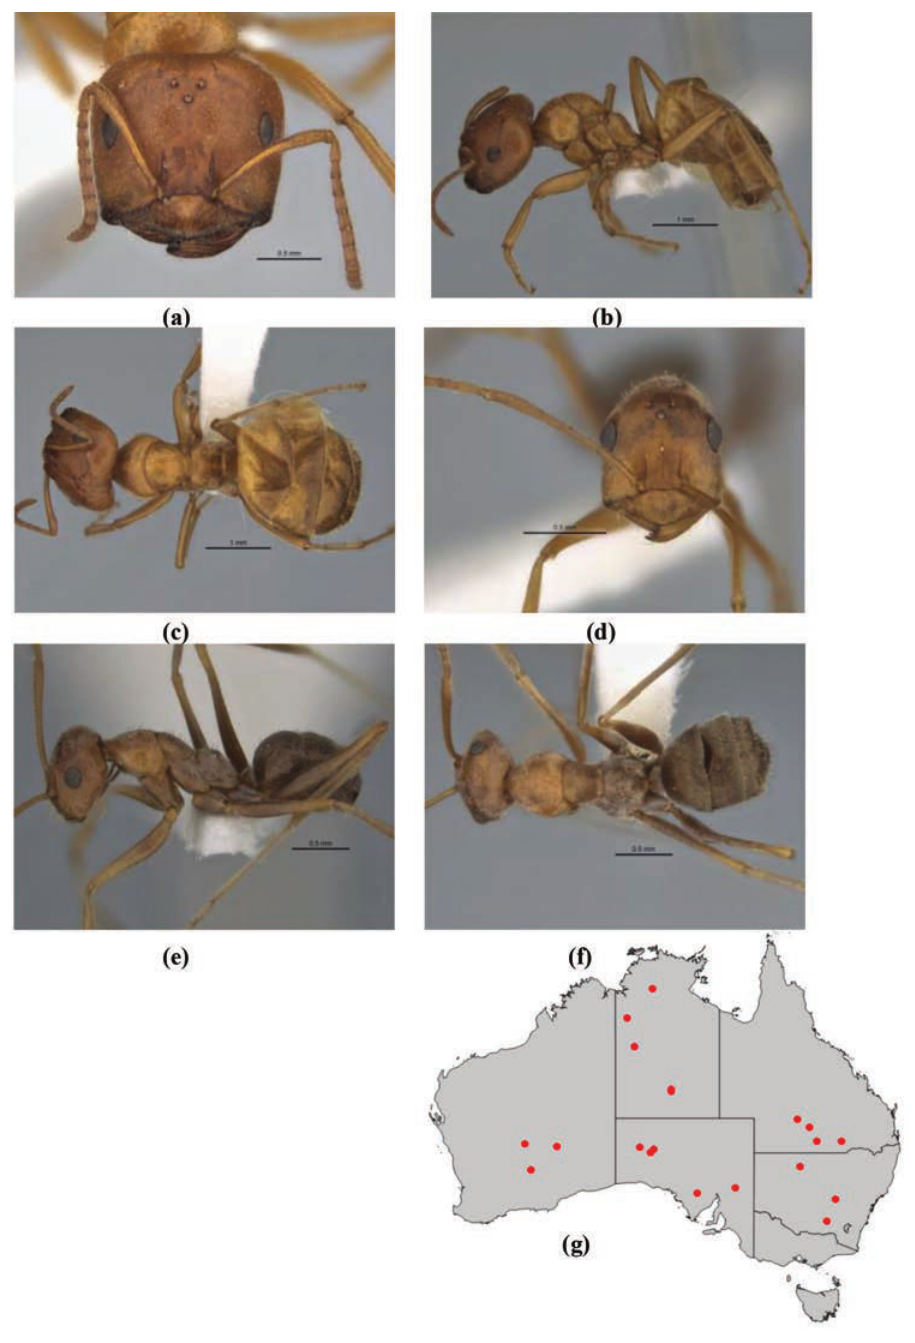
Figure 39. Melophorus lissotriches sp. n.: major worker paratype (ANIC32-900148–top ant) frons ( a ), pro- file ( b ) and dorsum ( c ); minor worker holotype (ANIC32-900148–bottom ant) frons ( d ), profile ( e ) and dorsum ( f ); distribution map for the species ( g ). Low resolution scale bars: 1 mm ( b, c ); 0.5 mm ( a, d–f